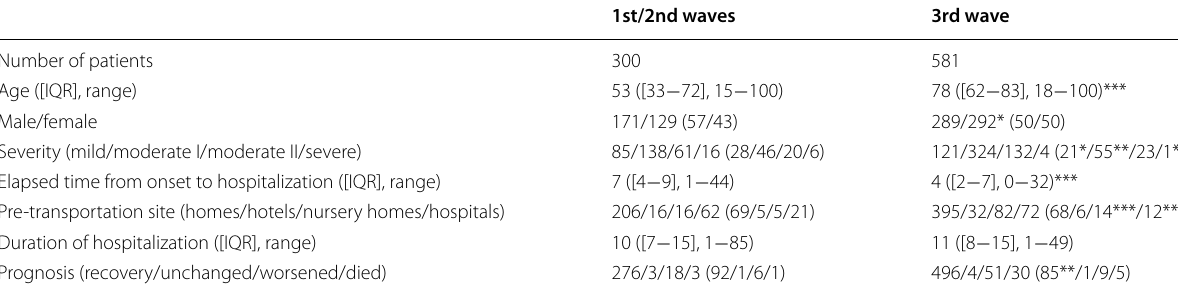
Data are expressed as the number of patients (percentage) or median ([25 75% interquartile range], range). 1st/2nd waves include patients admitted from March 25 − to September 14, 2020. 3rd wave includes patients from September 15, 2020, to March 2, 2021. Data during the 1st/2nd waves were from reference no. 3 * p < 0.05, ** p < 0.01, *** p < 0.001 compared with the 1st/2nd waves